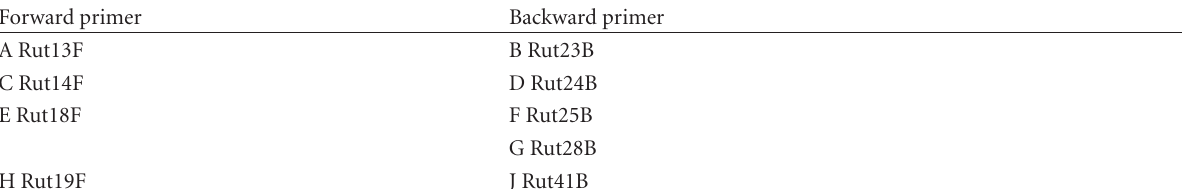
Table 1: Primer used for PCR (for localisation of primers along the cDNA, see Figure